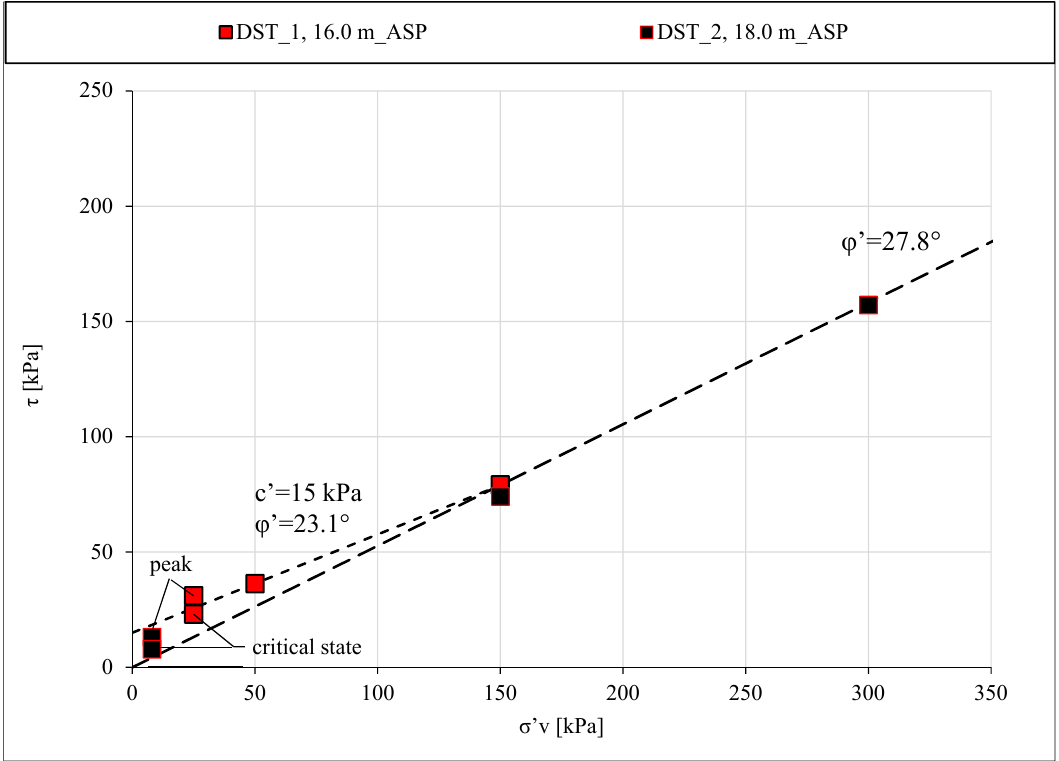
Figure 8. Photographs of a dry direct shear test (DST) specimen from the top layer rich in shell fragments.